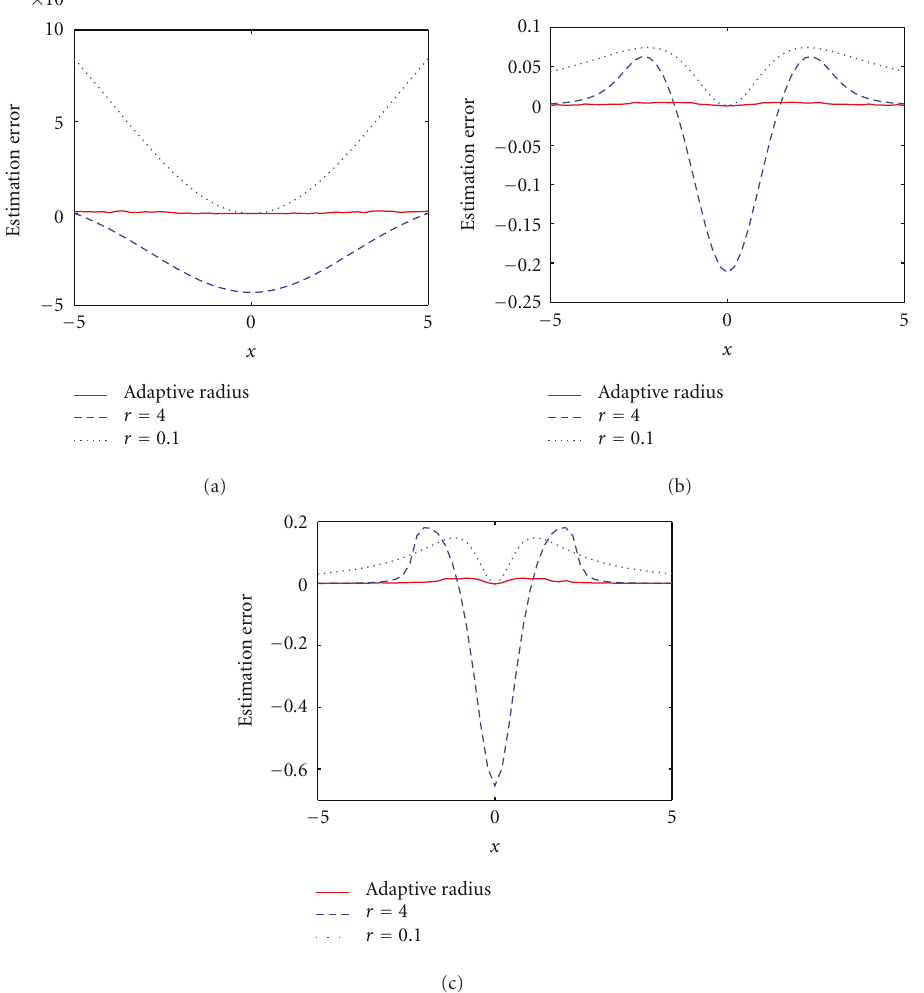
Figure 5: The estimation errors in Figures 4(b), 4(d), and 4(f) are shown in (a), (b), and (c),